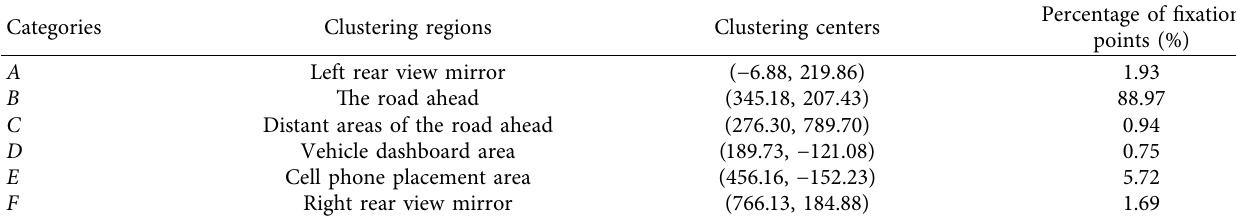
Table 2: Hierarchical clustering results of fxation